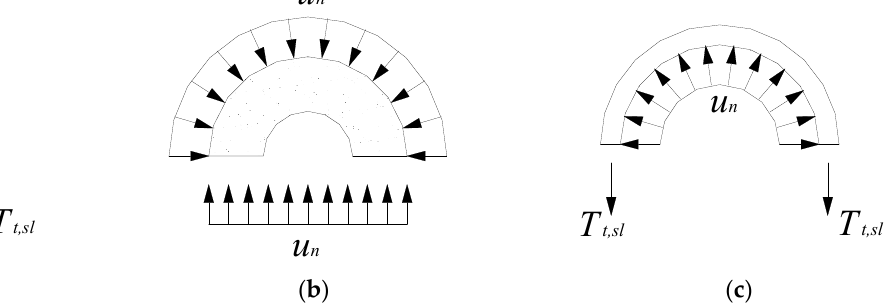
Figure 16. Stress diagram of the isolated body for the grouted splice sleeve. ( a ) Sleeve-grout. ( b ) Grout. ( c ) Sleeve.